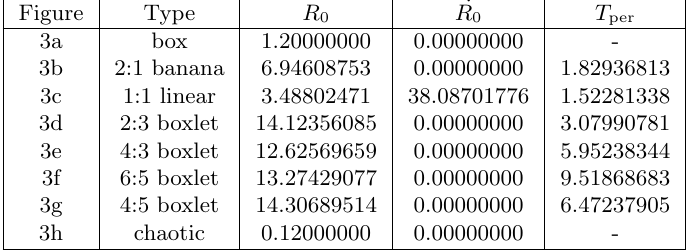
chaotic 0.12000000 0.00000000